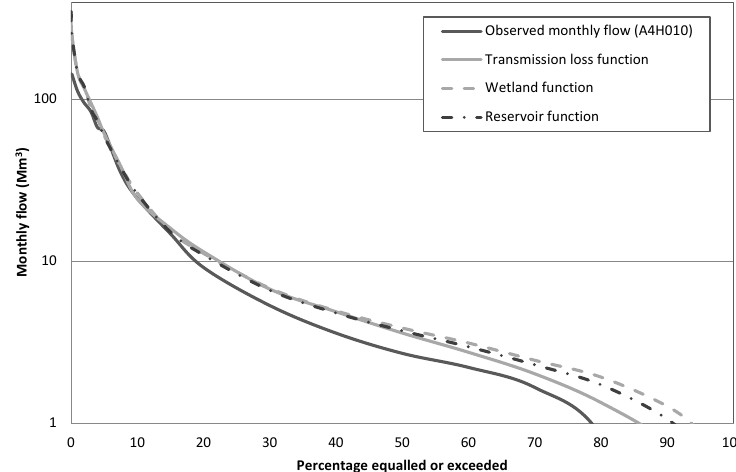
Figure 2. Comparison of flow volumes (Mm 3 ) at selected flow duration curve percentage points for the Mokolo